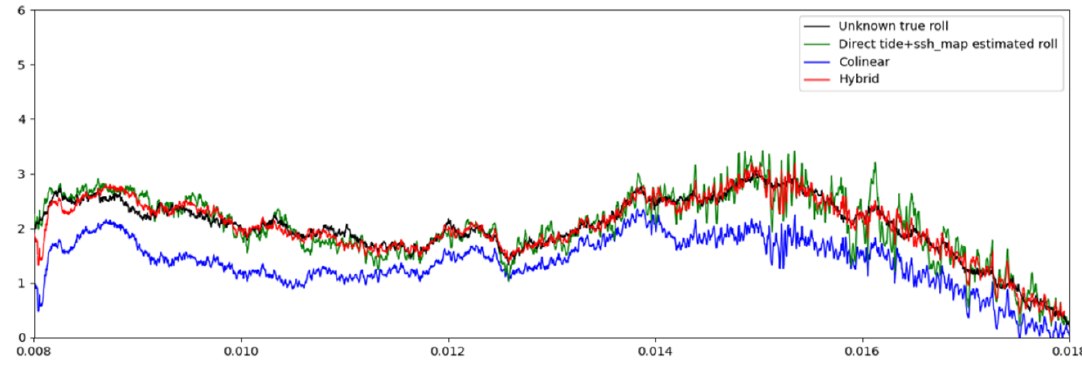
Figure 14. Same example as Figure 12a, with the collinear Method. The black line is the uncalibrated roll error to be retrieved. The green line is the roll retrieved with the Level-3 direct method (red curve of Figure 12a). The blue line is the roll retrieved with the collinear Method. The red line is when we combine the Direct and collinear Methods into a so-called Hybrid solution.